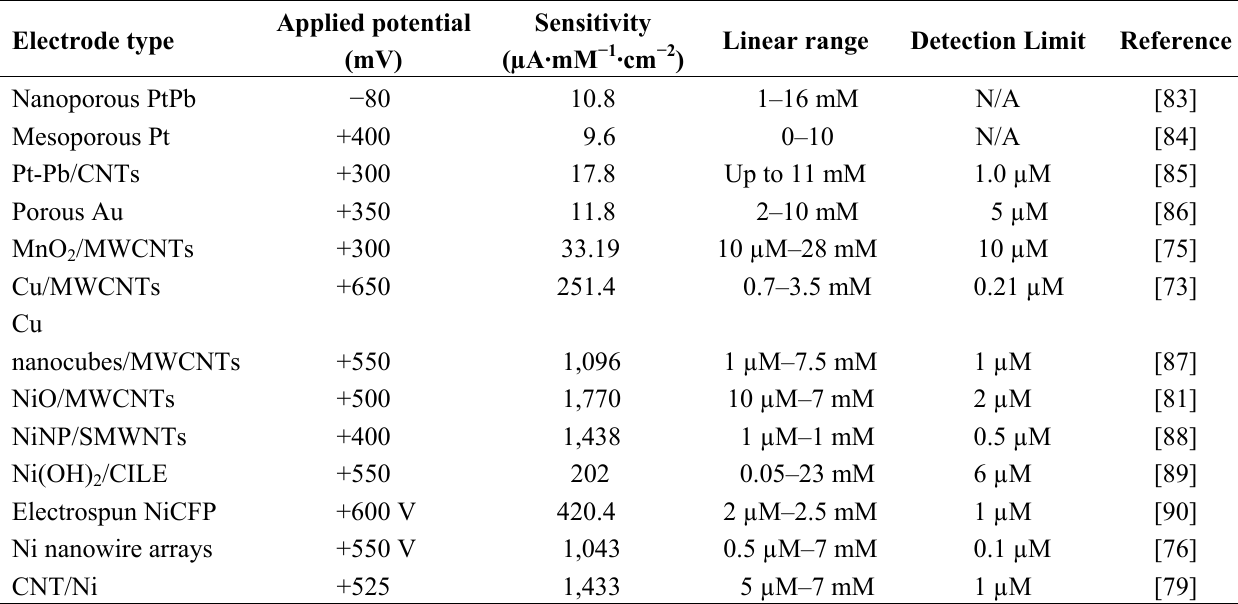
Table 1. Comparison of analytical performance of CNT/Ni nanocomposite sensor with different nonenzymatic glucose biosensors